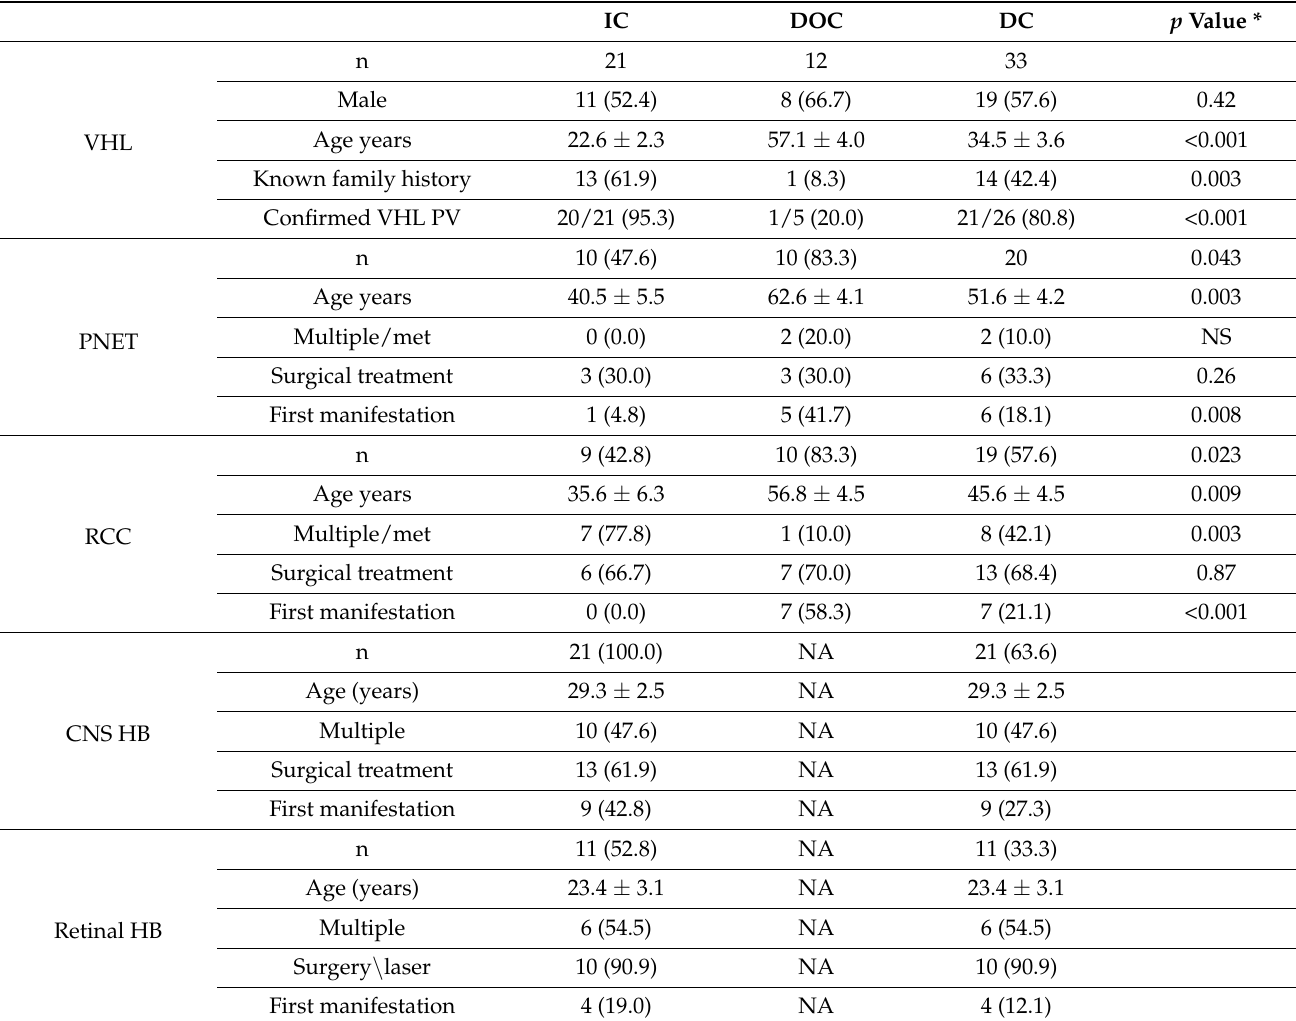
Table 5. Comparison of VHL manifestations between patients diagnosed with VHL based on the IC or the DOC. IC DOC